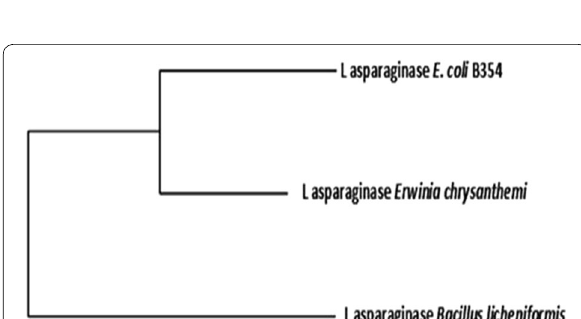
Fig. 2 Molecular phylogenetic analysis by maximum likelihood method of Bacillus licheniformis l -asparaginase (accession WP_075750324) when blasted against amino acid sequences of the FDA approved l -asparaginases of E. coli and Erwinia